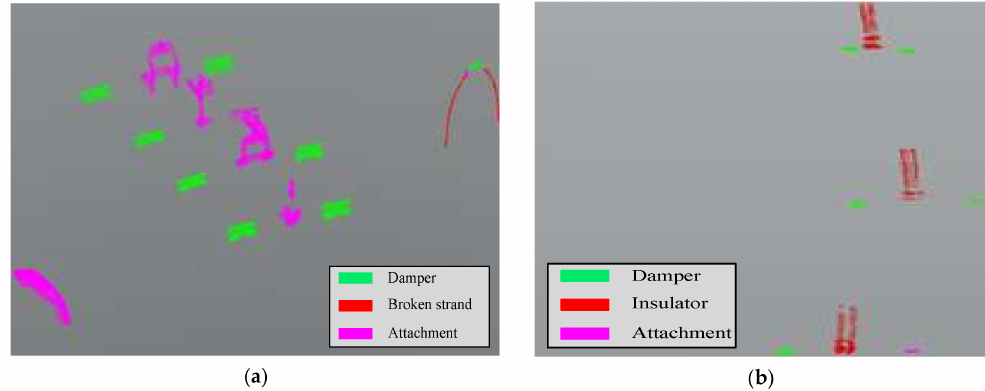
Figure 12. Object recognition of the second dataset ( a ), the third dataset ( b ) in SPL partition.